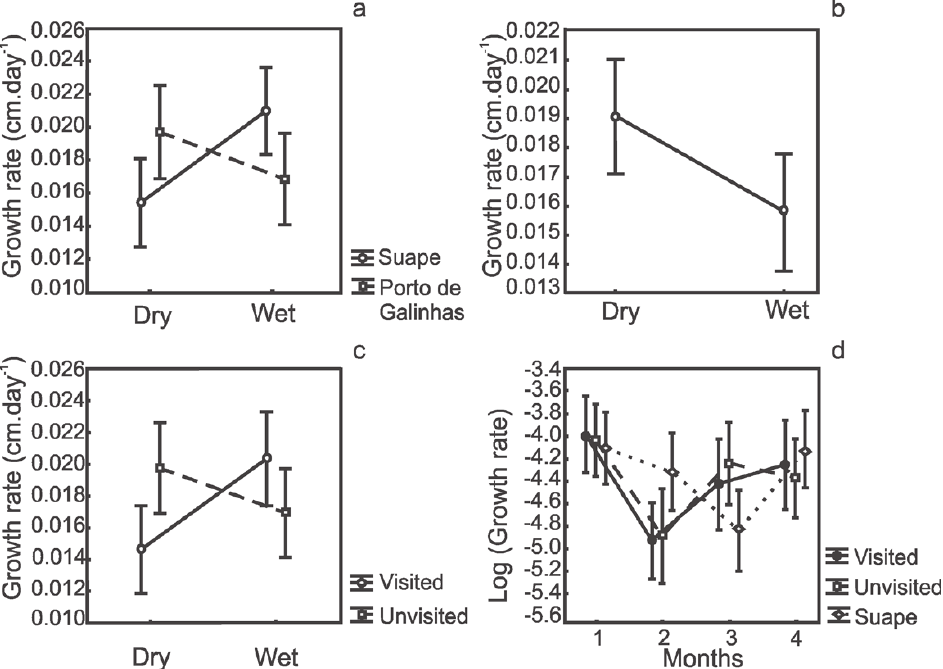
Figure 3 - Comparison of Palythoa caribaeorum growth rate (cm.day -1 ) between a. Suape and Porto de Galinhas beaches during dry and wet seasons; b. dry and wet seasons in a pooled analysis with intertidal and infralittoral data of Porto de Galinhas beach; c. visited and unvisited Porto de Galinhas beachrocks during dry and wet seasons; d. visited and unvisited Porto de Galinhas beachrocks and Suape beach during months. Data are presented as means ± SE. In Figure 3D, data were converted in Log